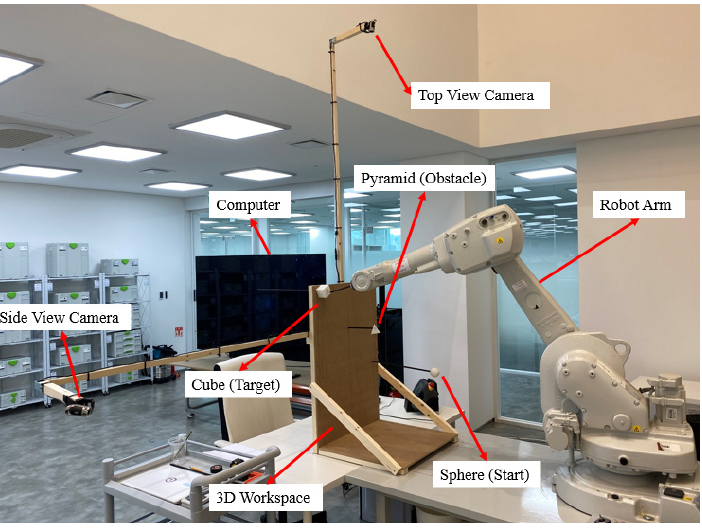
Figure 8. Experimental setup: cameras, robot arm, workspace, sphere (start), pyramid (obstacle), cube (target).